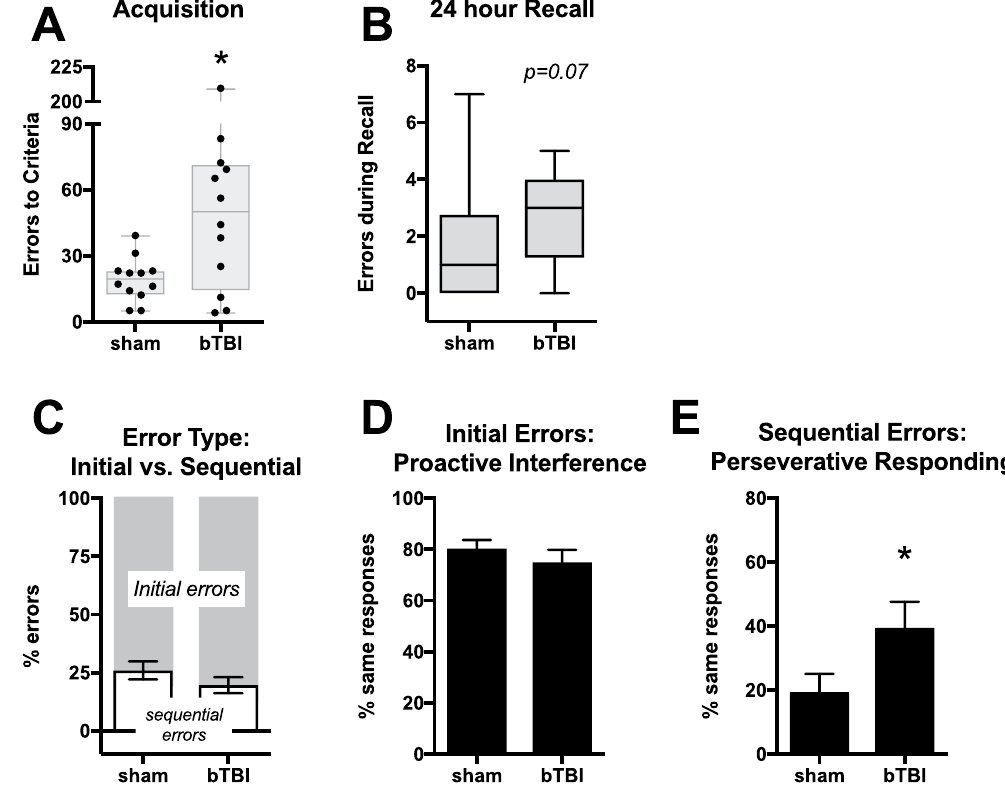
Figure 2. Acquisition and recall of the visual-cue discrimination task. ( A ) Number of errors committed during acquisition of task. ( B ) Number of errors committed in a 20-trial recall test performed 24 hours following acquisition criteria were met. ( C ) Proportion of errors during acquisition that were initial (not preceded by an incorrect trial) and sequential (preceded by an incorrect trial). ( D ) Proportion of initial errors that were committed on the same side as the previous trial. ( E ) Proportion of sequential errors during acquisition that were committed on the same side as the previous trial. Boxes represent median and quartiles, whiskers represent range, symbols are individual values. Bars represent mean ± SEM. N = 12/group. * p ≤